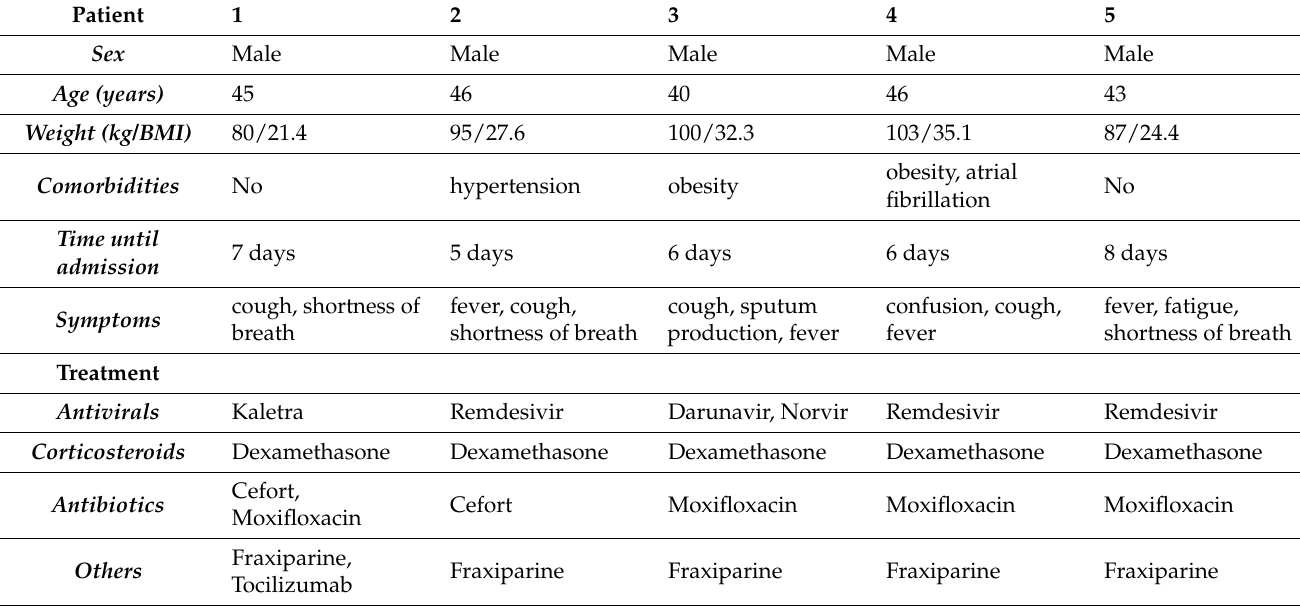
Table 1. Clinical characteristics and associated treatment of patients who received convalescent plasma